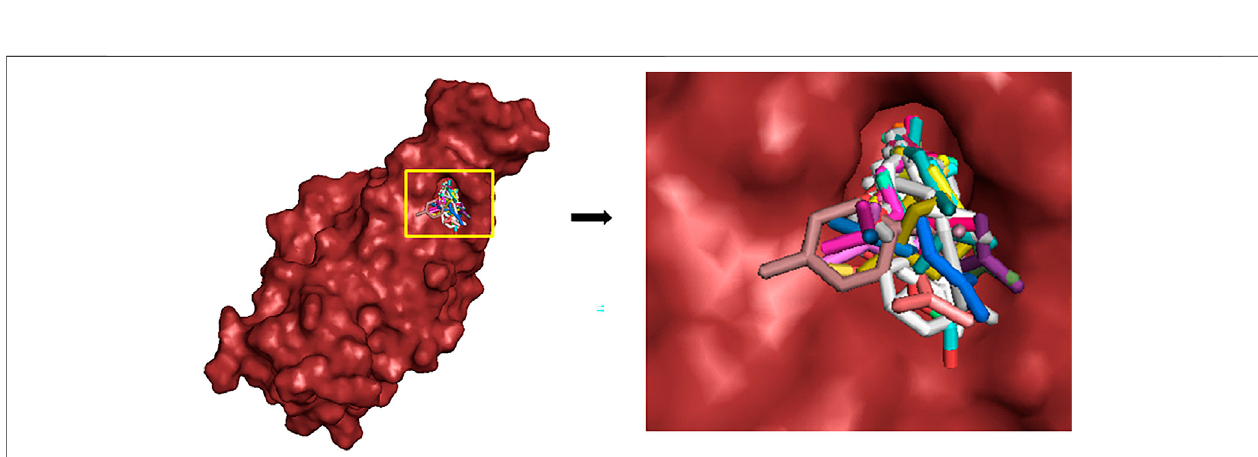
FIGURE 3 | Ligands docked in the binding site of the RBD of S protein.